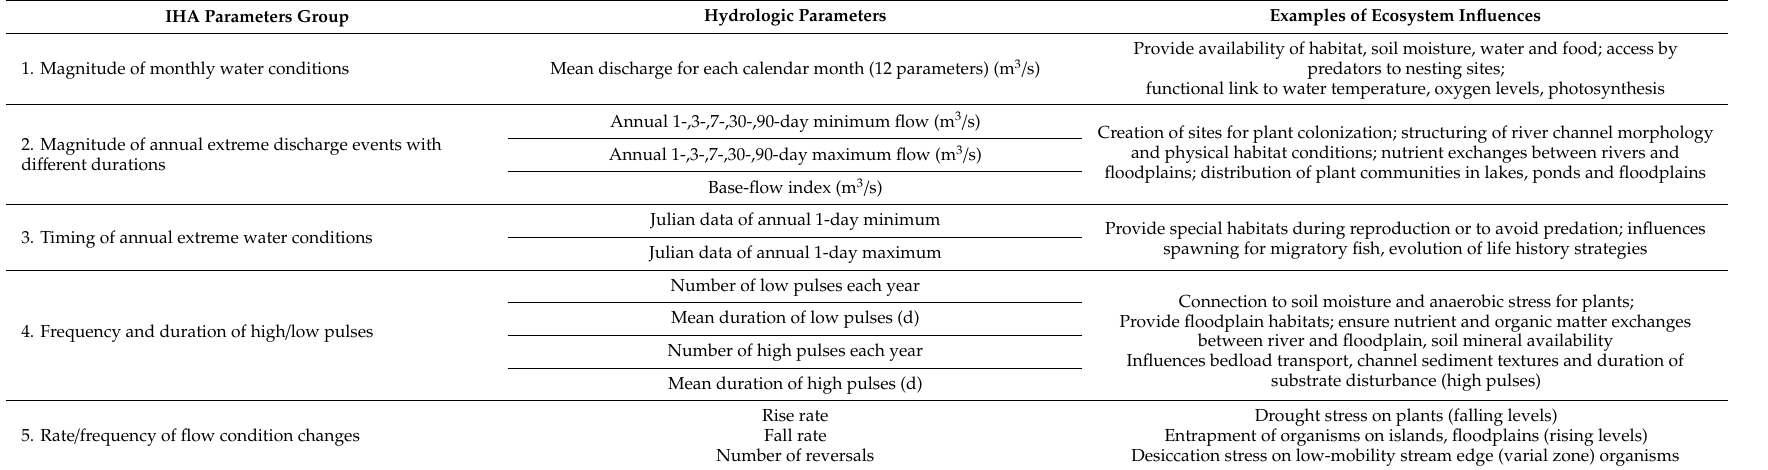
Table 1. The 32 indicators of hydrologic alteration (IHAs)